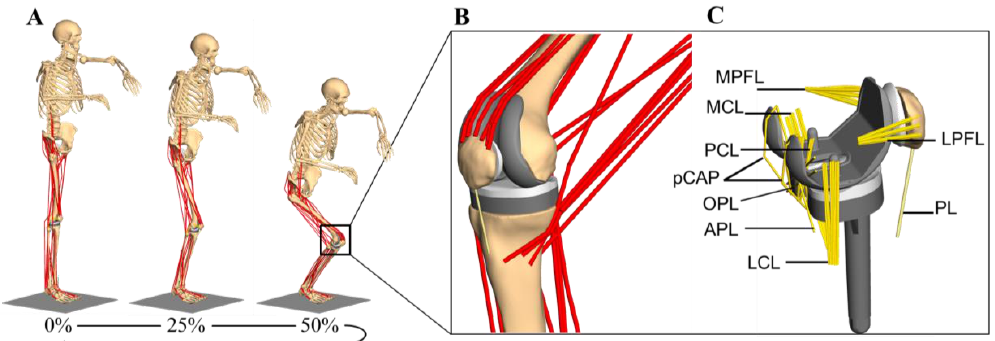
Figure 2. The developed musculoskeletal multibody simulation model with a cruciate-retaining total knee replacement in the lower right extremity during a dynamic squat motion combining musculoskeletal motion dynamics, knee implants with articular contact definitions, muscles, and ligaments ( A ). Detailed representation of the knee joint with implant components and muscle structures, including muscle wrapping. Note that ligaments are not shown for the sake of clarity ( B ).